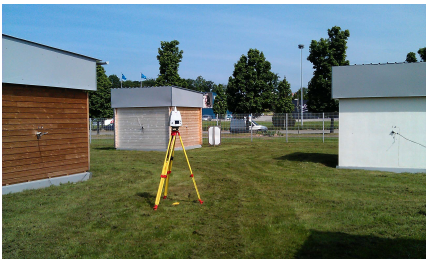
Figure 1: Test modules image